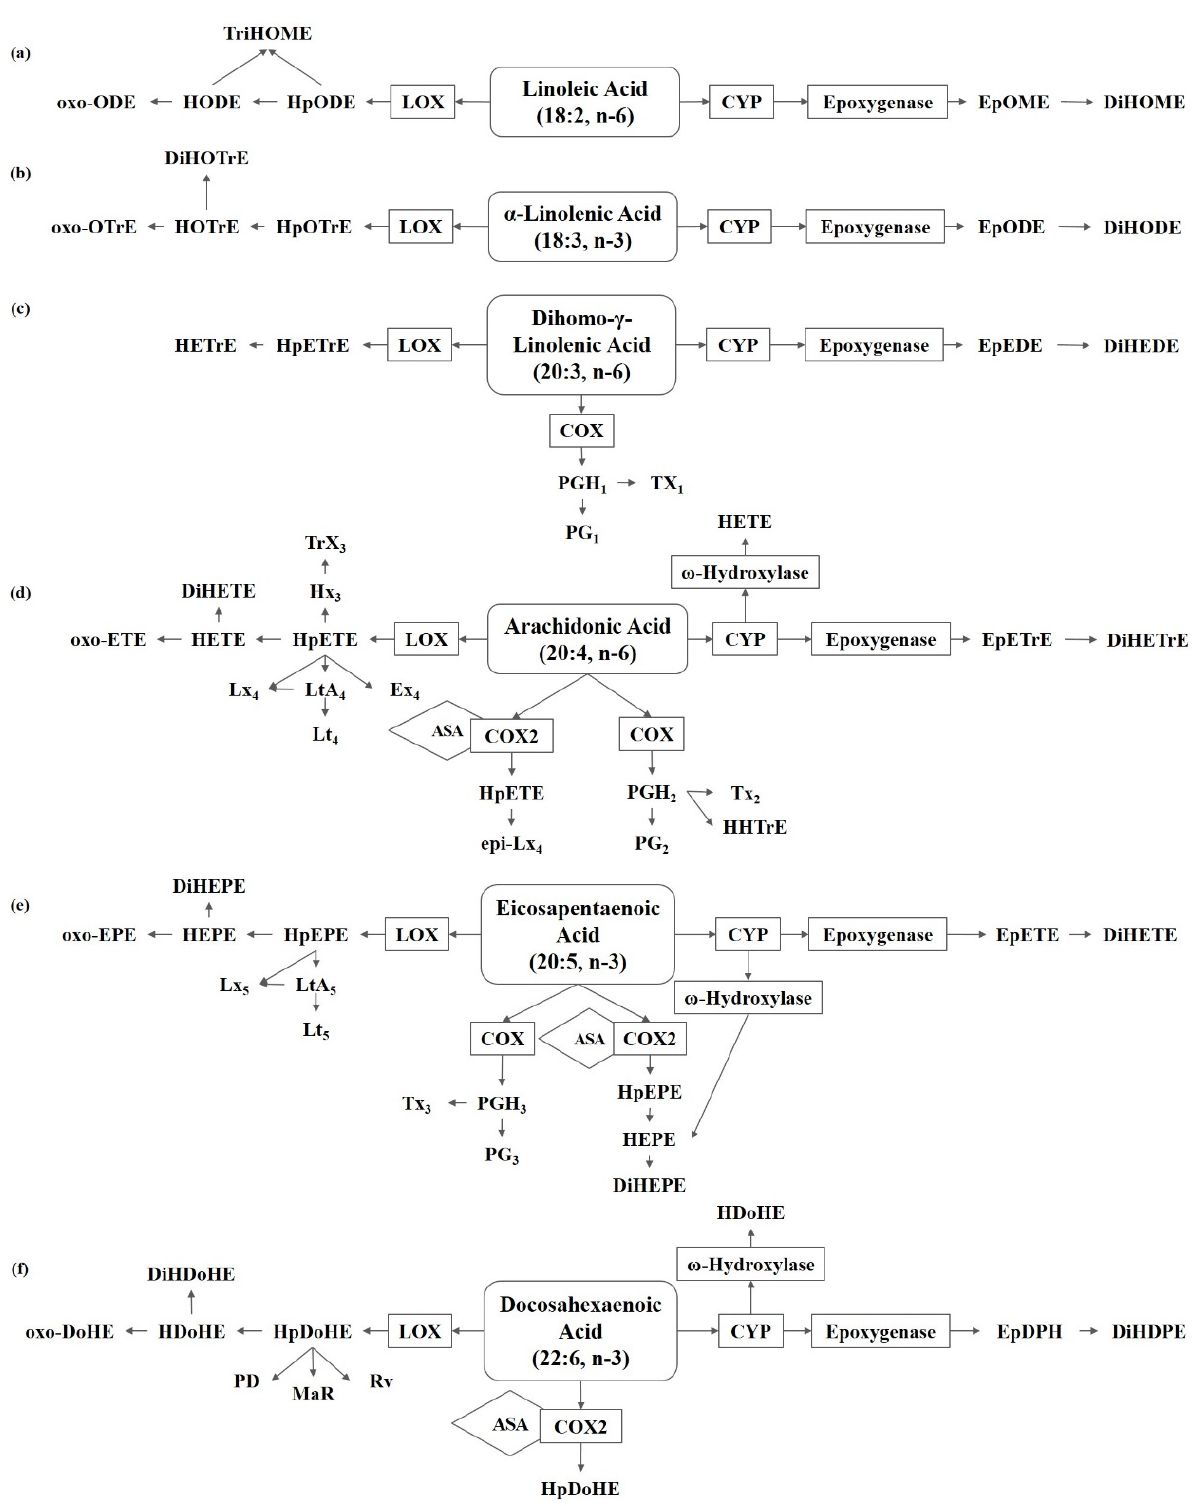
Figure 1. Metabolism of polyunsaturated fatty acids in fungi. ( a ) Linoleic acid (LA) derived oxylipins. ( b ) α -Linolenic acid (ALA) derived oxylipins. ( c ) Dihomo- γ -linolenic acid (DGLA) derived oxylipins. ( d ) Arachidonic acid (ARA) derived oxylipins. ( e ) Eicosapentaenoic acid (EPA) derived oxylipins. ( f ) Docosahexaenoic acid (DHA) derived oxylipins. ASA, acetylsalicylic acid; COX, cy- clooxygenase; CYP, cytochrome P450; DiHDoHE, dihydroxy − docosahexaenoic acid; DiHDPE, di- hydroxy − docosapentaenoic acid; DiHEDE, dihydroxy − eicosadienoic acid; DiHEPE dihydroxy- eicosapentaenoic acid; DiHETE, dihydroxy − eicosatetraenoic acid; DiHETrE, dihydroxy − eicosa- trienoic acid; DiHODE, dihydroxy − octadecadienoic acid; DiHOME, dihydroxy − octadecenoic acid; DiHOTrE, dihydroxy − octadecatrienoic acid; EpDPE, epoxy − docosapentaenoic acid; EpEDE, epoxy − eicosadienoic acid; EpETE, epoxy − eicosatetraenoic acid; EpETrE, epoxy − eicosatrienoic acid; EpODE, epoxy − octadecadienoic acid; EpOME, epoxy − octadecenoic acid; Ex, eoxin; HDoHE, hy- droxyl − docosahexaenoic acid; HEPE, hydroxyl − eicosapentaenoic acid; HETE, hydroxyl − eicosatet- raenoic acid; HETrE, hydroxy − eicosatrienoic acid; HHTrE, hydroxyl − heptadecatrienoic acid; HODE, hydroxy − octadecadienoic acid; HOTrE, hydroxy − octadecatrienoic acid; HpDoHE, hydrop-